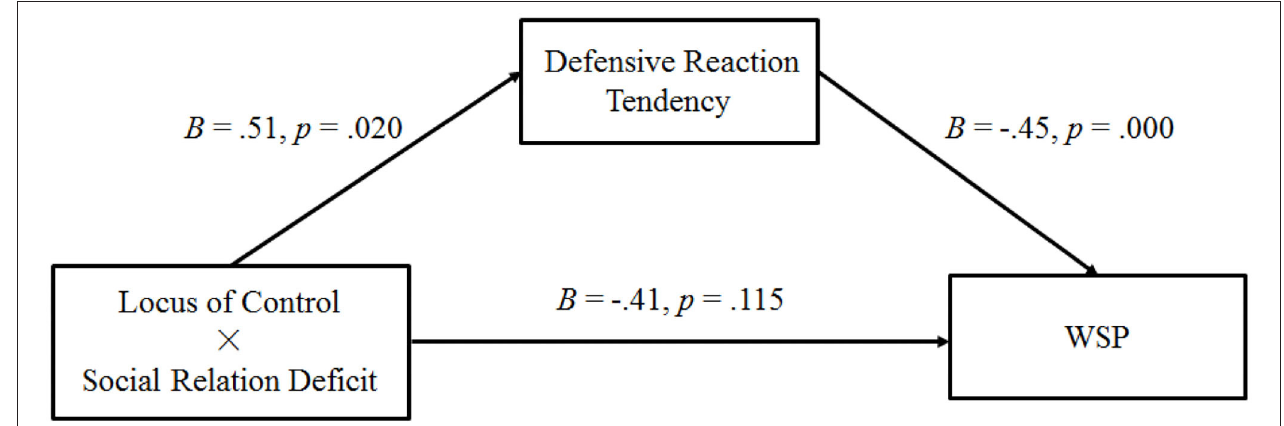
FIGURE 4 | Results of Experiment 2: path analysis of Experiment 2 (WSP, willingness to purchase self-improvement products).